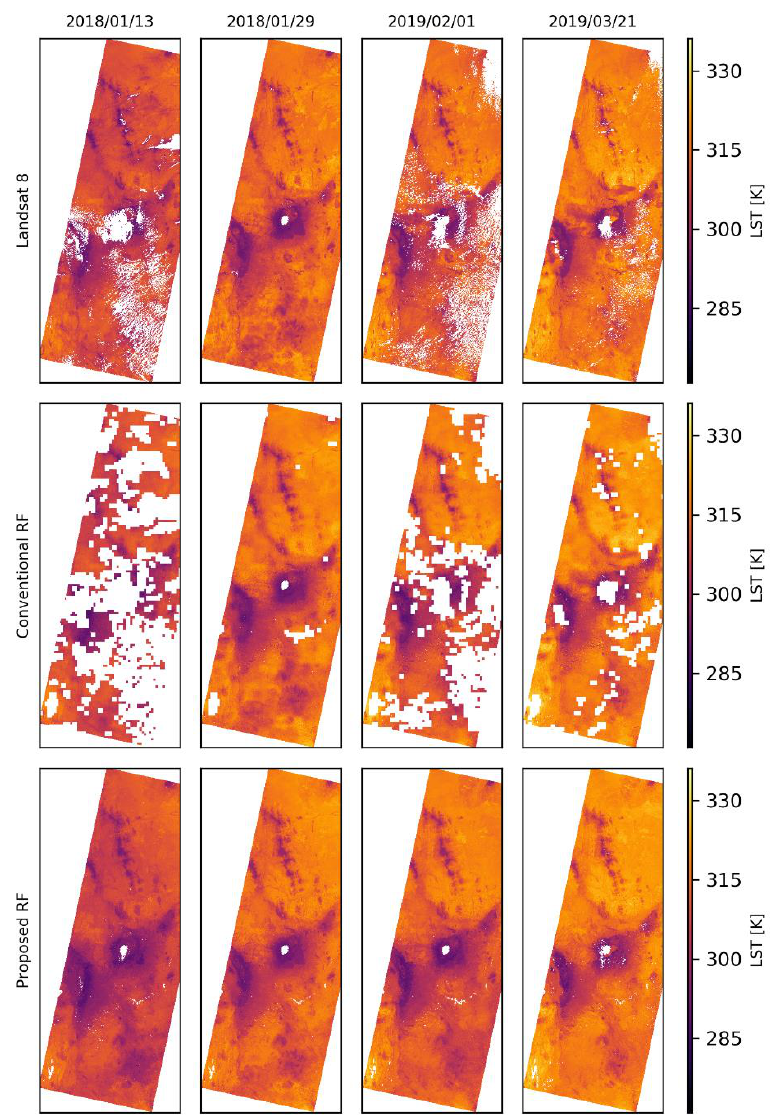
Figure 6. LST maps derived from Landsat 8 ( top ) and the downscaled LST maps ( middle and bottom ) corresponding to orbit 168 of Landsat 8 for the four Landsat 8 overpass days used in the study.